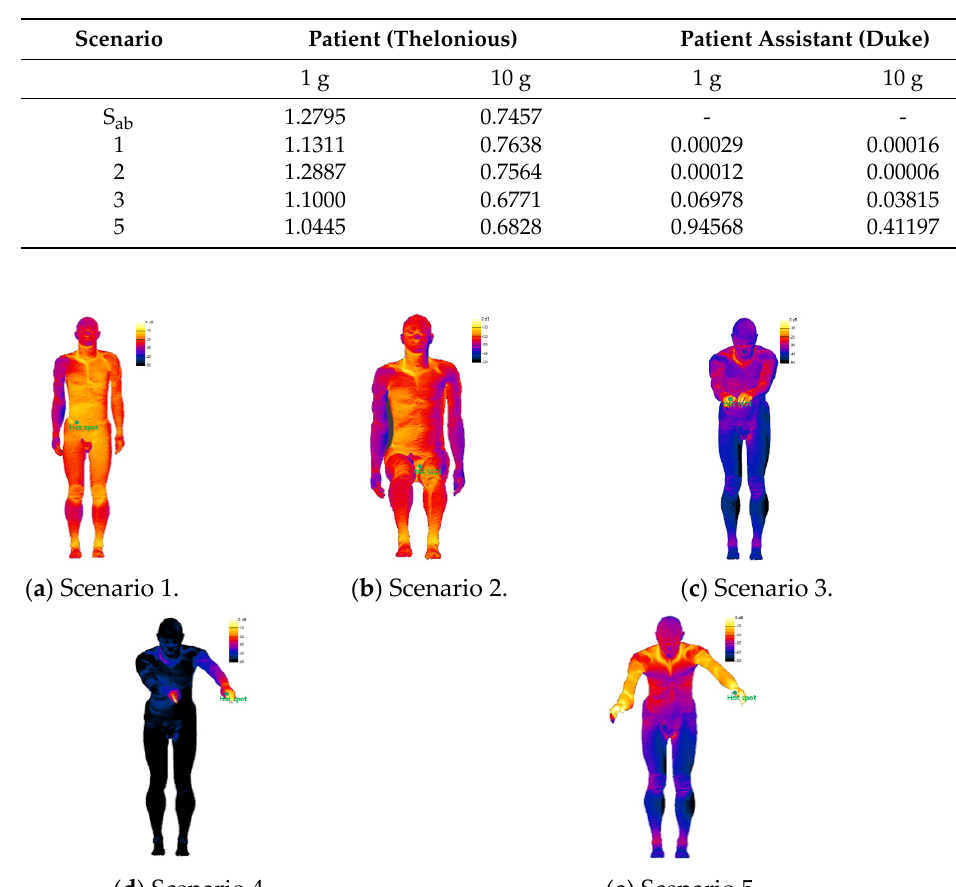
Figure 6. The 1 g SAR distributions of the patient assistant (Duke) when Billie was the patient for different scenarios: ( a ) 1, ( b ) 2, ( c ) 3, ( d ) 4, ( e ) 5 (same dB and color scale). Table 2. Peak spatially averaged SAR (W/kg) in Billie (patient) and Duke (patient assistant) ac- cording to head RF coil (input power = 1 W).